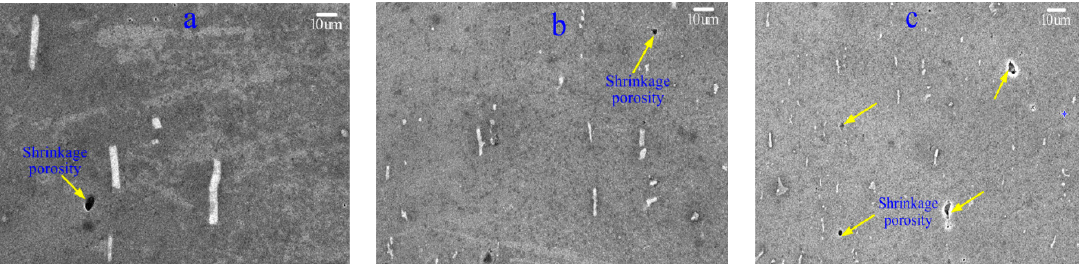
Figure 7. SEM morphologies of samples: ( a ) matrix; ( b ) LP ‐ treated (1.8 J + 25 °C); ( c ) WLP ‐ treated (1.8 J + 120 °C).